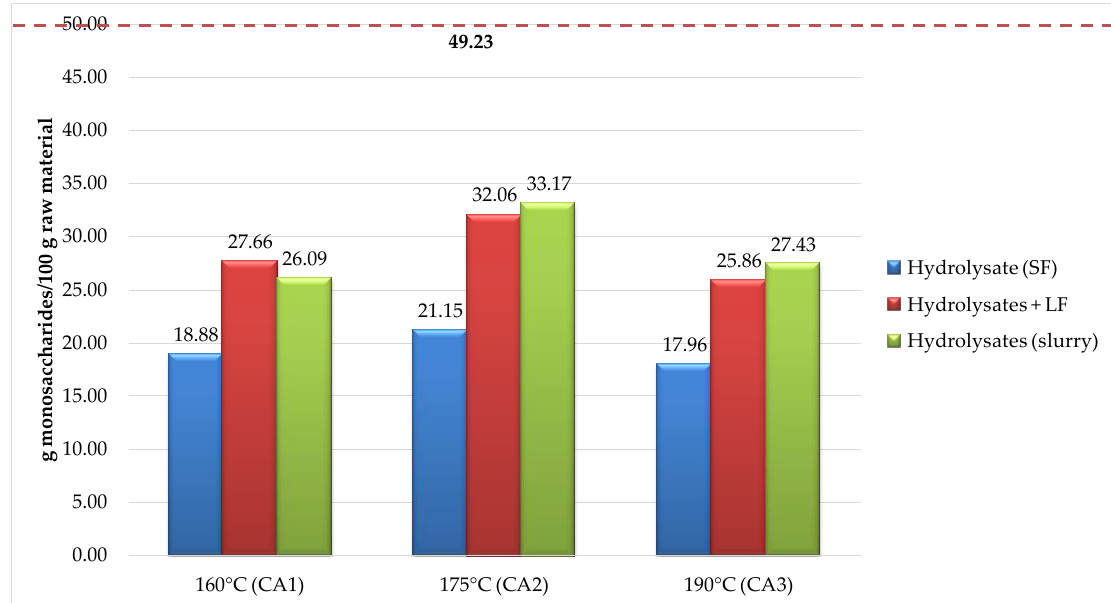
Figure 5. Total amount of monosaccharides recovered after pre-treatment and enzymatic hydrolysis; the dashed line corresponds to the maximum theoretical value.